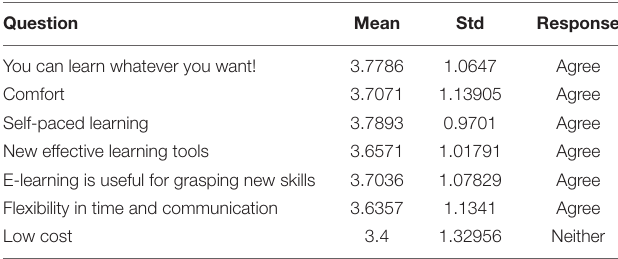
TABLE 5 | The challenges of online teaching and learning during the COVID-19 pandemic.